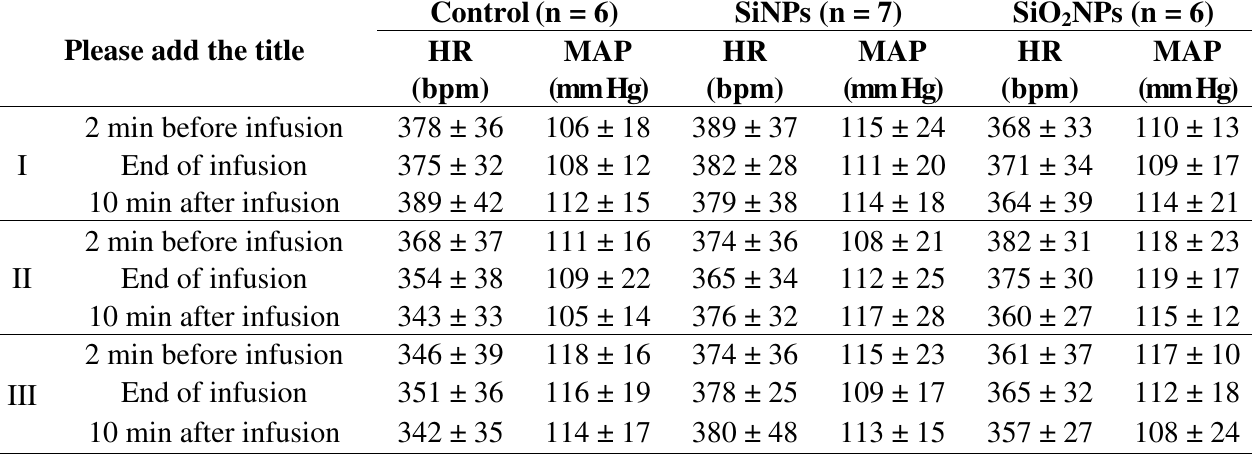
Table 2. The effect of intravenous administration of silicon and silica nanoparticles on hemodynamic parameters in rats. HR—heart rate; MAP—mean arterial